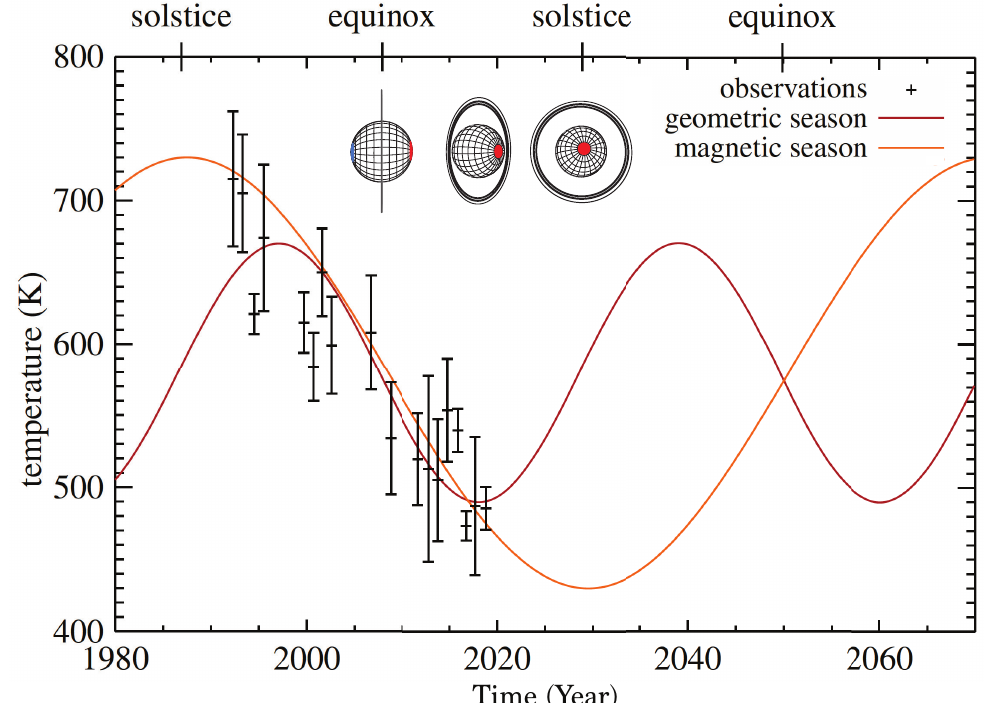
Figure 9. The long-term H + temperature trend measured at Uranus. Geometric and magnetic 3 seasons are over-plotted and described in the main text. Inside the figure, a simple schematic view is provided to illustrate the changing configuration of Uranus over time, with a red cap added to a single hemisphere to guide the eye. Figure adapted from